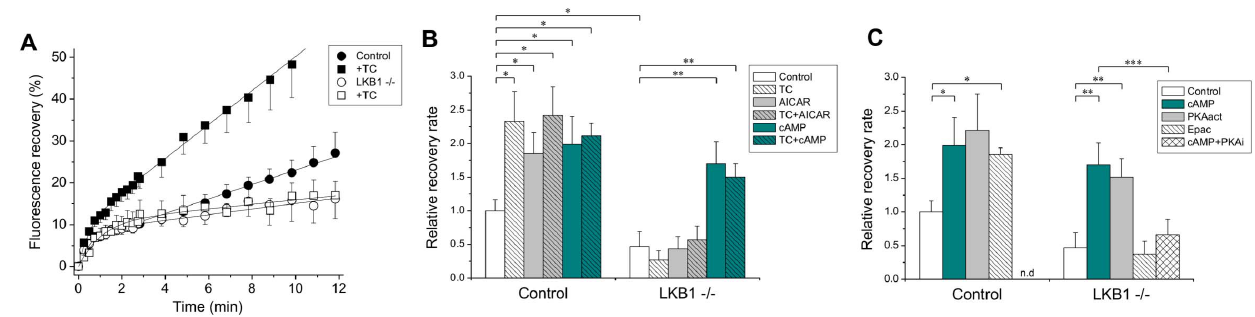
Figure 4. ABCB11 trafficking in control and LKB1 2 / 2 hepatocytes. ( A ) FRAP studies with control and LKB1 2 / 2 mouse hepatocytes N transduced with YFP-tagged ABCB11 were performed as described in detail in Figs. 2 and 3. The second phase of fluorescence recovery was markedly ). Taurocholate (TC) accelerated the fluorescence recovery only in control slower in the LKB1 2 / 2 cells ( # ) as compared to control cells ( hepatocytes ( & ), and had no effect in LKB1 2 / 2 cells ( % ). ( B–C ) The slopes of the second recovery phase (parameter B in the equation), which reflect initial rate of canalicular trafficking, were averaged and normalized to the untreated wild type cells. Pretreatments: TC – 100 m M taurocholate, AICAR - 500 m M AICAR, cAMP - 200 m M 8-Br-cAMP, PKAact - 50 m M 6-Bnz-cAMP, Epac - 3 m M 8-CTP-cAMP, PKAi - 500 nM PKA inhibitor. Means 6 S.E.M. of at least three independent experiments are shown. Asterisks denote significant differences as compared to untreated control hepatocytes (*), to untreated LKB1 2 / 2 cells (**), or to 8-Br-cAMP-treated cells (***), p , 0.05. n.d. – not determined. Taurocholate, AICAR, and cAMP accelerated canalicular trafficking of ABCB11 in control hepatocytes. The effects were not additive. Basal level of ABCB11 trafficking to the canaliculi was reduced in the LKB1 2 / 2 cells as compared to control cells. Taurocholate and AICAR were ineffective in these cells, however, the effect of cAMP persisted. Activation of PKA resulted in accelerated canalicular trafficking in both cell types, whereas inhibition of PKA abolished the effect of cAMP in LKB1- deficient